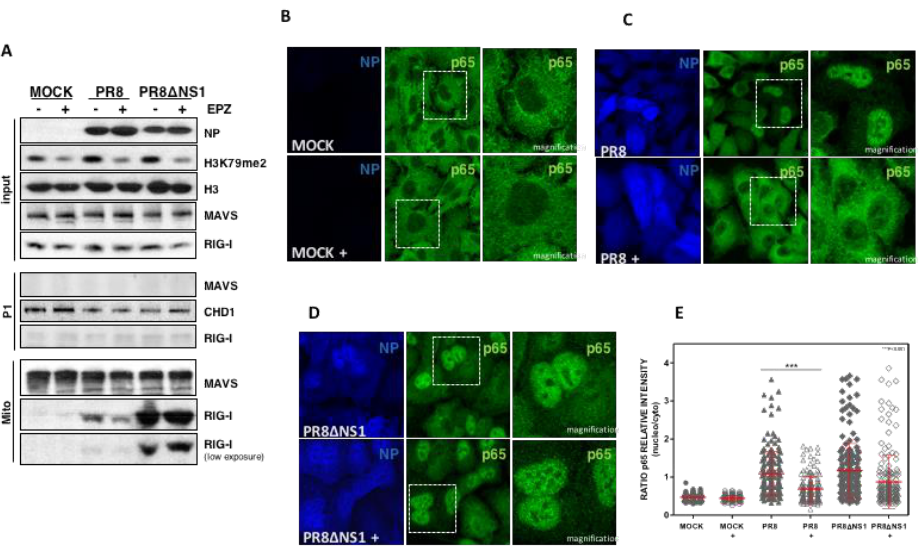
Figure 5. Dot1L inhibition does not modify RIG-I-MAVS interaction and nuclear translocation of NF- κ B in delNS1 infection. ( A ) Control or EPZ-treated cells were left uninfected (MOCK), or infected with PR8 or with delNS1 virus at MOI 3. Input, P1 (P1) and purified mitochondria (Mito) fractions were used for Western blot analysis against the indicated proteins. ( B ) A549 cells were plated in the presence or absence of EPZ 1 µM and 48 h later, the cells were processed for immunofluorescence using anti-p65. ( C – D ) Cells were processed as in ( B ) and then infected at MOI 3 with PR8 at 8 h ( C ), or delNS1 at 16 h ( D ). EPZ was present all throughout the experiment in the EPZ-treated cells. The experiment was repeated twice, and representative images are shown. ( E ) Nuclear NF- κ B translocation was measured by orthogonal projection image analysis and quantified in at least 200 cells/condition. The ratio was calculated by quantitation of the relative p65 intensity in the nucleus and the cytoplasm of each cell in all different conditions. Ratios are shown in dispersion graphs. ns p > 0.05; * p < 0.05; ** p < 0.01; *** p < 0.001.